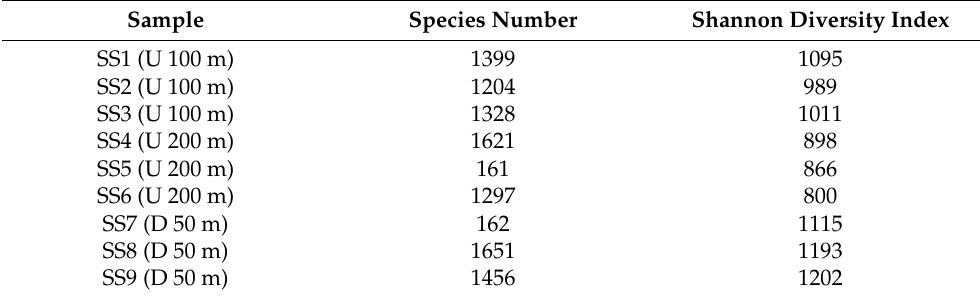
Table 1. The total species number and Shannon diversity index, upstream vs. downstream. Note the lower diversity well upstream of the landfill site and the increased diversity around the AMD influence and downstream. Sites SS5 and SS7 had an order of magnitude lower total species number than the site in general and this reflected the patchy nature of the site. Abbreviations: SS—sample site, U—upstream, D—downstream. Species Number Shannon Diversity